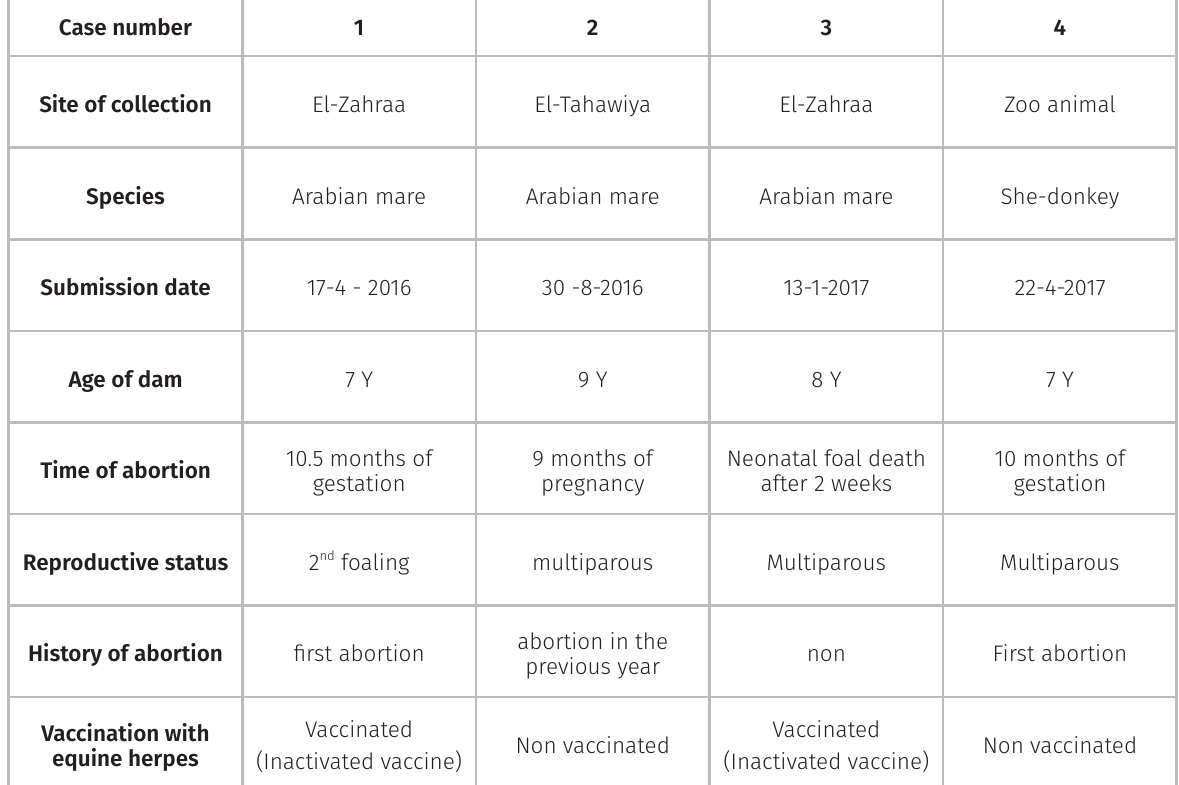
(CPE) on CAM in form of pock lesion after 5-6 days of incubation at 37°C. The pock lesion was 3rd passage. Viral identification by PCR (extraction of DNA)